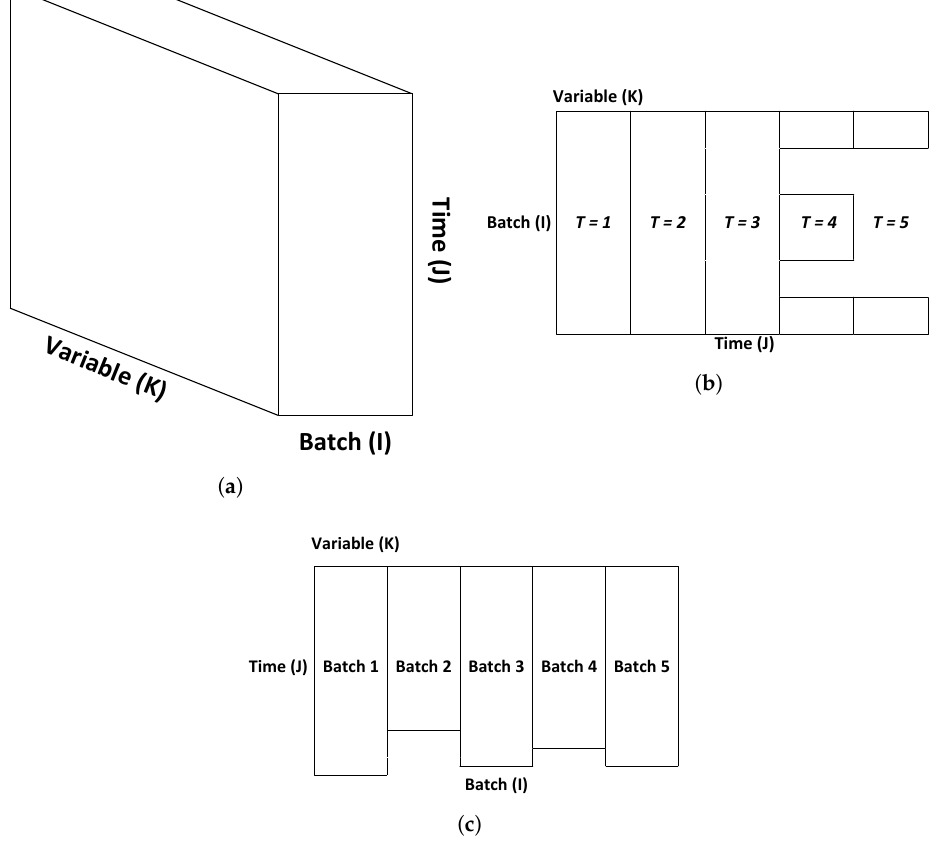
Figure 6. Unfolding of batch data. ( a ) Batch data in three dimensions; ( b ) batch-wise unfolding; ( c ) time-wise